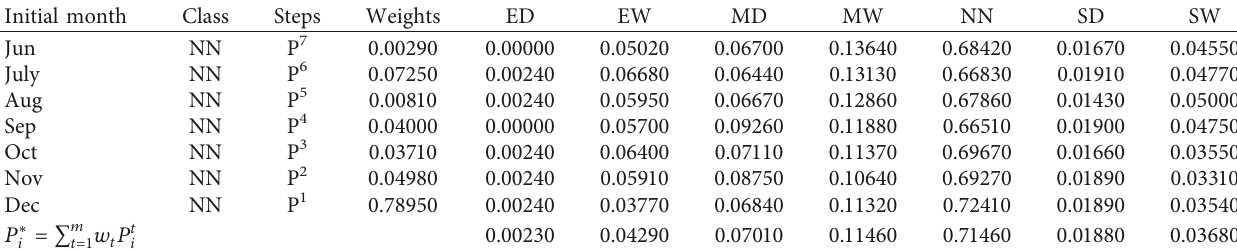
Table 3: Predicted probabilities of next drought classes at Astor